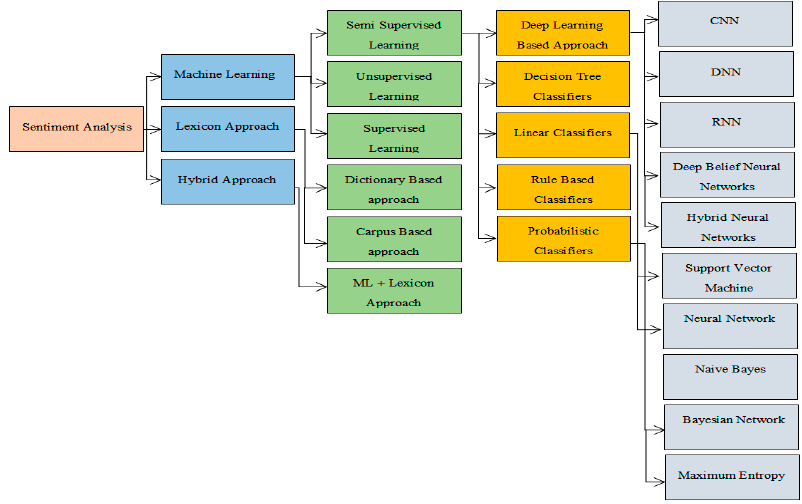
Figure 1. Taxonomic classification of sentiment analysis [22].